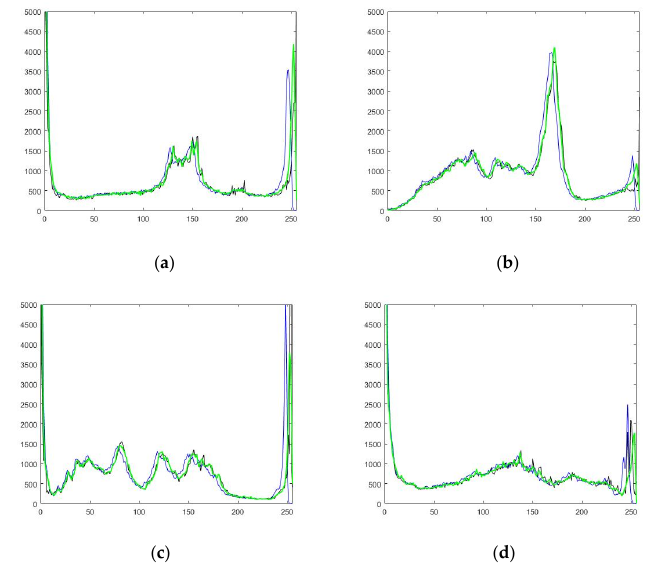
Figure 8. Histogram comparison between the ground truth (black line), the output without refinement (blue line), and the output with refinement (green line) on cross-domain action categories from the UCF101 dataset. Each diagram corresponds to a same-label-group in Figure 7. The correlation coefficient between the histograms of two pairs of frames, which are the ground truth-the output without refinement and the ground truth-the output with refinement, are ( a ) 0.6855 and 0.8886, ( b ) 0.8731 and 0.9609, ( c ) 0.5298 and 0.8933 and ( d ) 0.7996 and 0.9767.